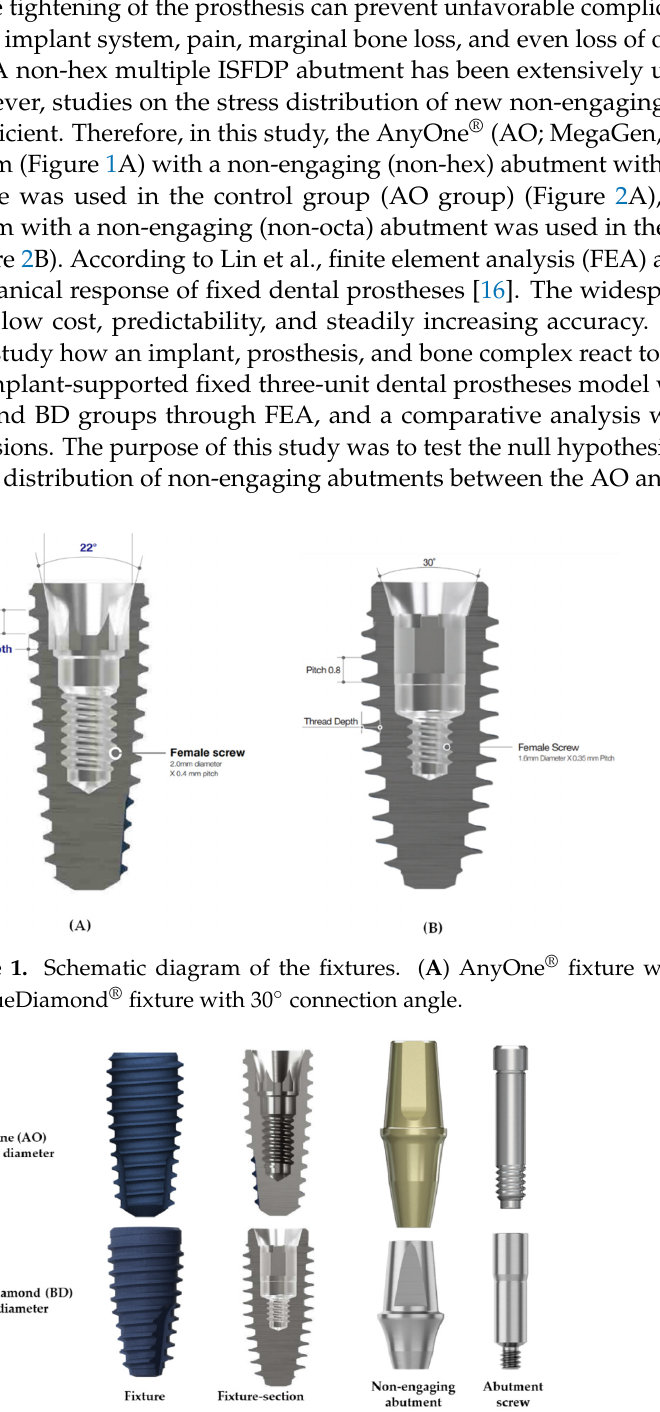
Figure 2. Designs and dimensions of the fixture, abutment, and abutment screw. ( A ) AnyOne ® fix- ture with 4.5 mm diameter; ( B ) BlueDiamond ® fixture with 4.4 mm diameter.